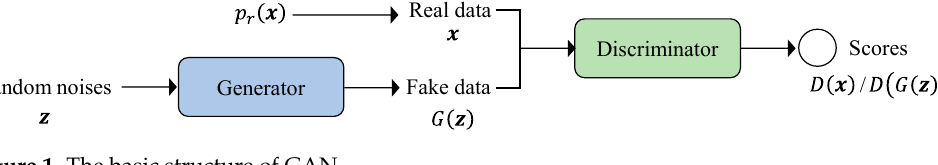
Figure 1. The basic structure of GAN.